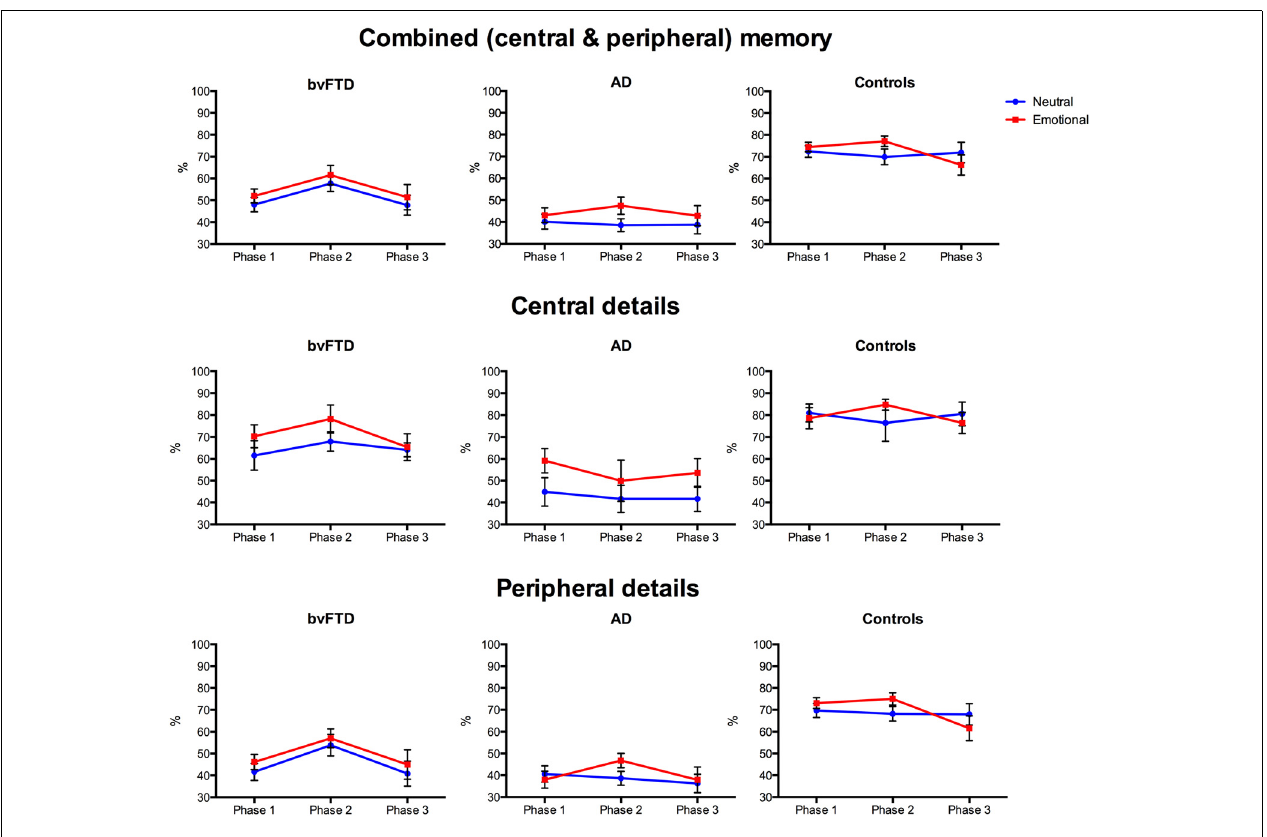
FIGURE 3 | Profiles of emotional memory performance in behavioral-variant frontotemporal dementia (bvFTD), Alzheimer’s disease (AD), and controls. Graphs show percent correct